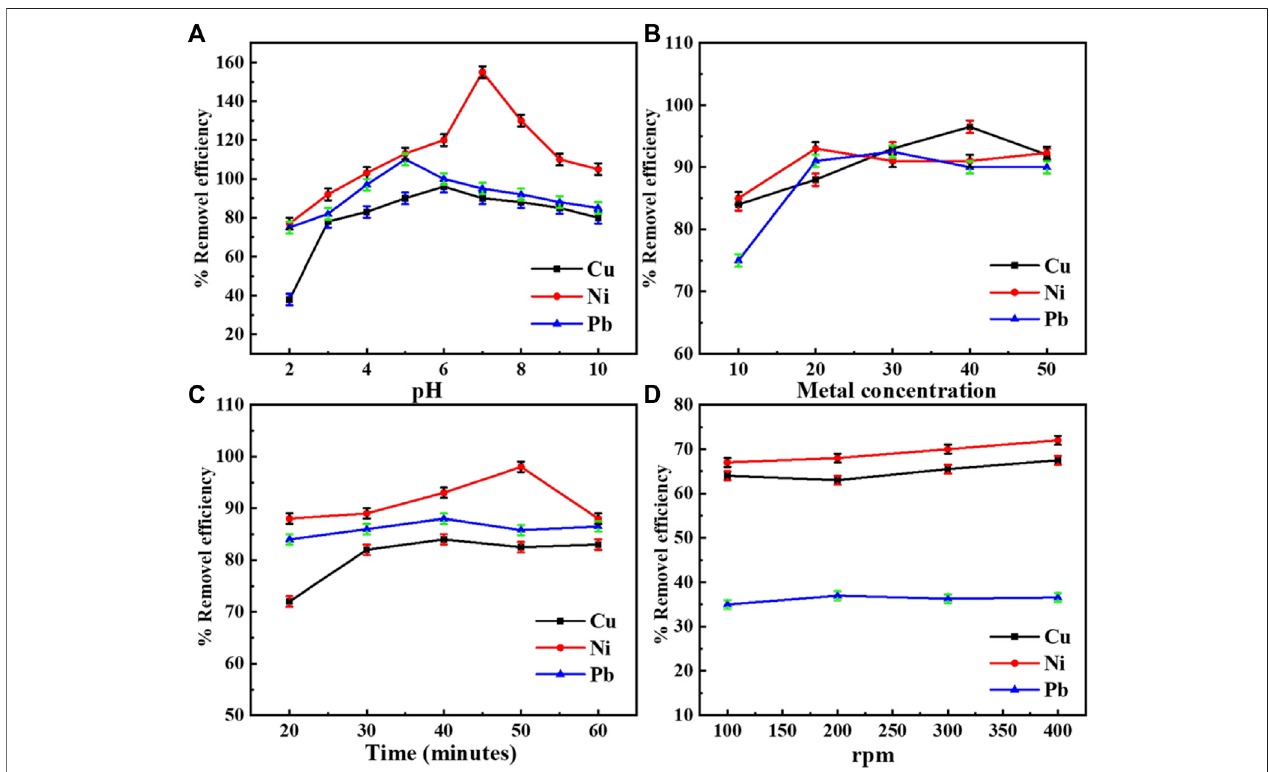
FIGURE5|(A) Percentageremovalef fi ciencyofCu,Pb,andNiatdifferentpHvalues. (B) Percentageremovalef fi ciencyofCu,Pb,andNiatdifferentinitialmetalion concentrations. (C) Percentage removal ef fi ciency of Cu, Pb, and Ni at different time intervals. (D) Percentage removal ef fi ciency of Cu, Pb, and Ni at varying agitation